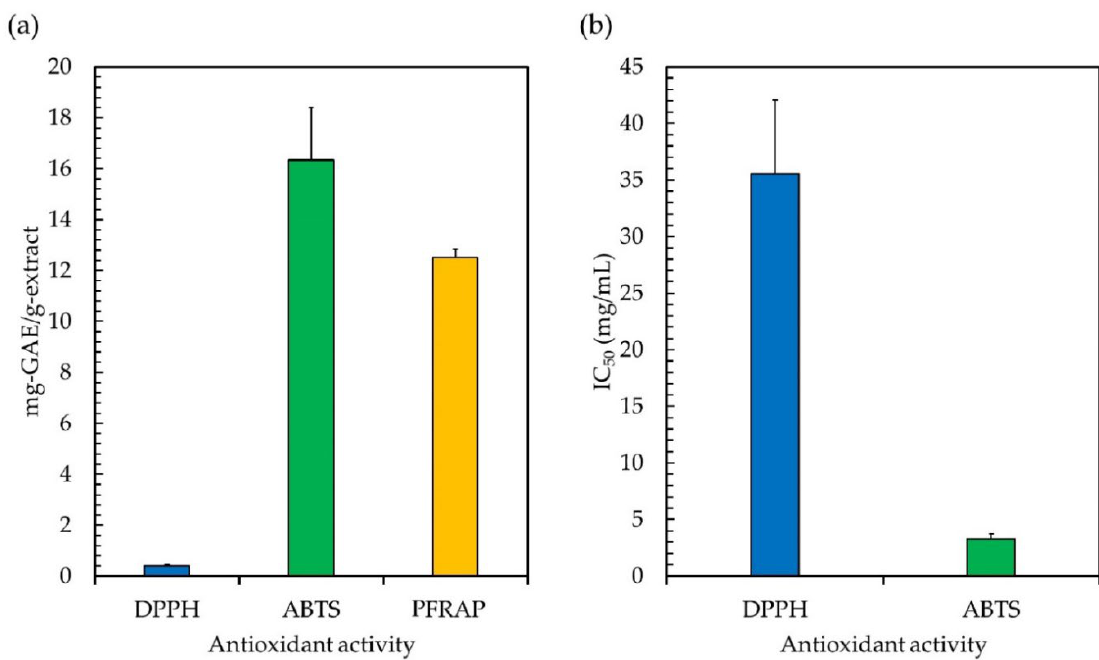
Figure 2. The gallic acid equivalent antioxidant capacity (mg-GAE/g-extract) ( a ) and the half maximal inhibitory concentration (IC 50 ; mg/mL) on 2,2-diphenyl-1-picrylhydrazyl (DPPH), 2,2’-azino-bis (3-ethylbenzthiazoline-6-sulfonic acid) (ABTS), and potassium-ferricyanide-reducing antioxidant power (PFRAP) ( b ) of the ethanolic extract from cyanobacteria, Leptolyngbya sp. KC45.